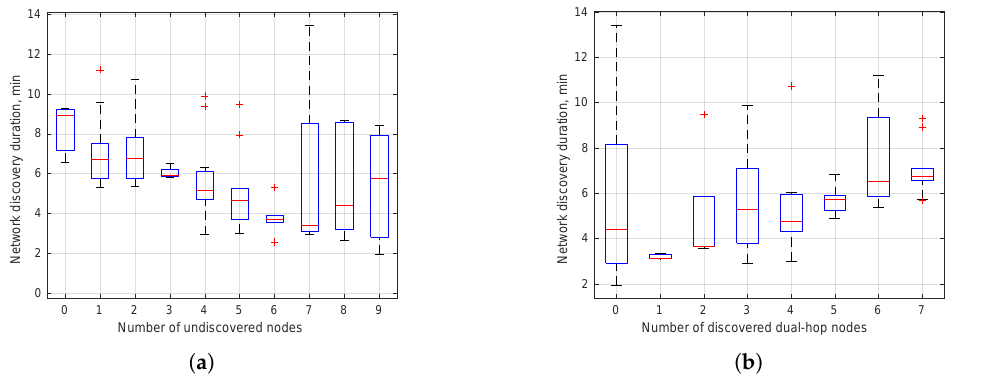
Figure 23. The duration of the network discovery cycles in the North Sea deployment is loosely correlated with the number of dual-hop nodes in the discovered topology, and with the number of undiscovered nodes (i.e., nodes that the gateway failed to connect with). ( a ) Network discovery duration vs the number of undiscovered nodes; ( b ) Network discovery duration vs. the number of discovered dual-hop